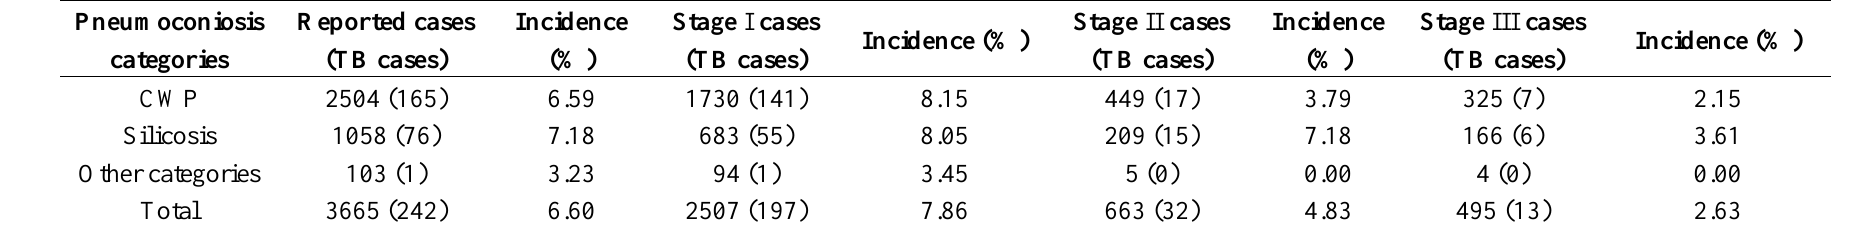
Table 4. Cases of pneumoconiosis complicated with pulmonary